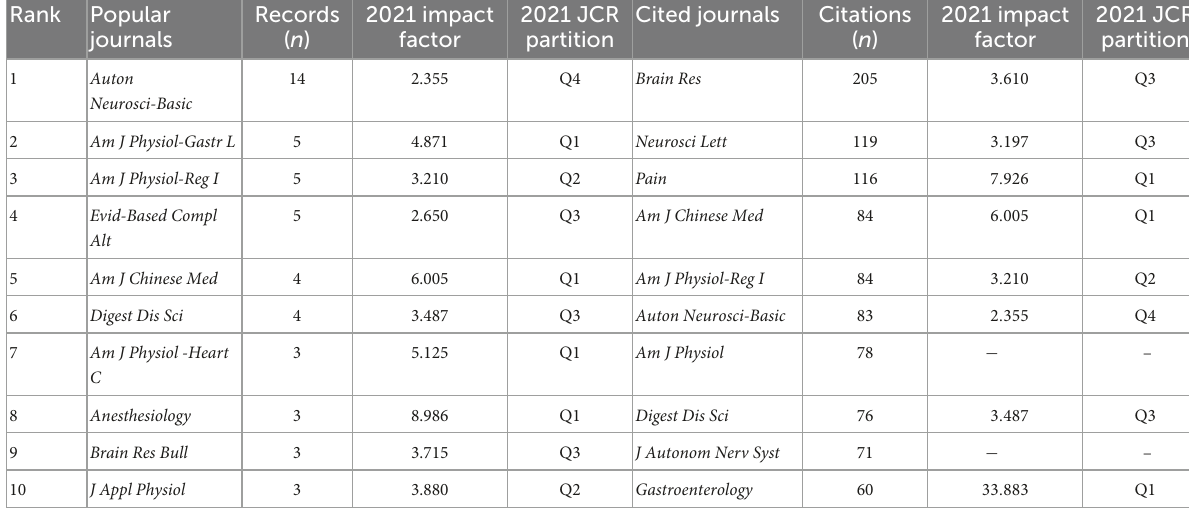
TABLE 4 Top 10 popular journals and cited